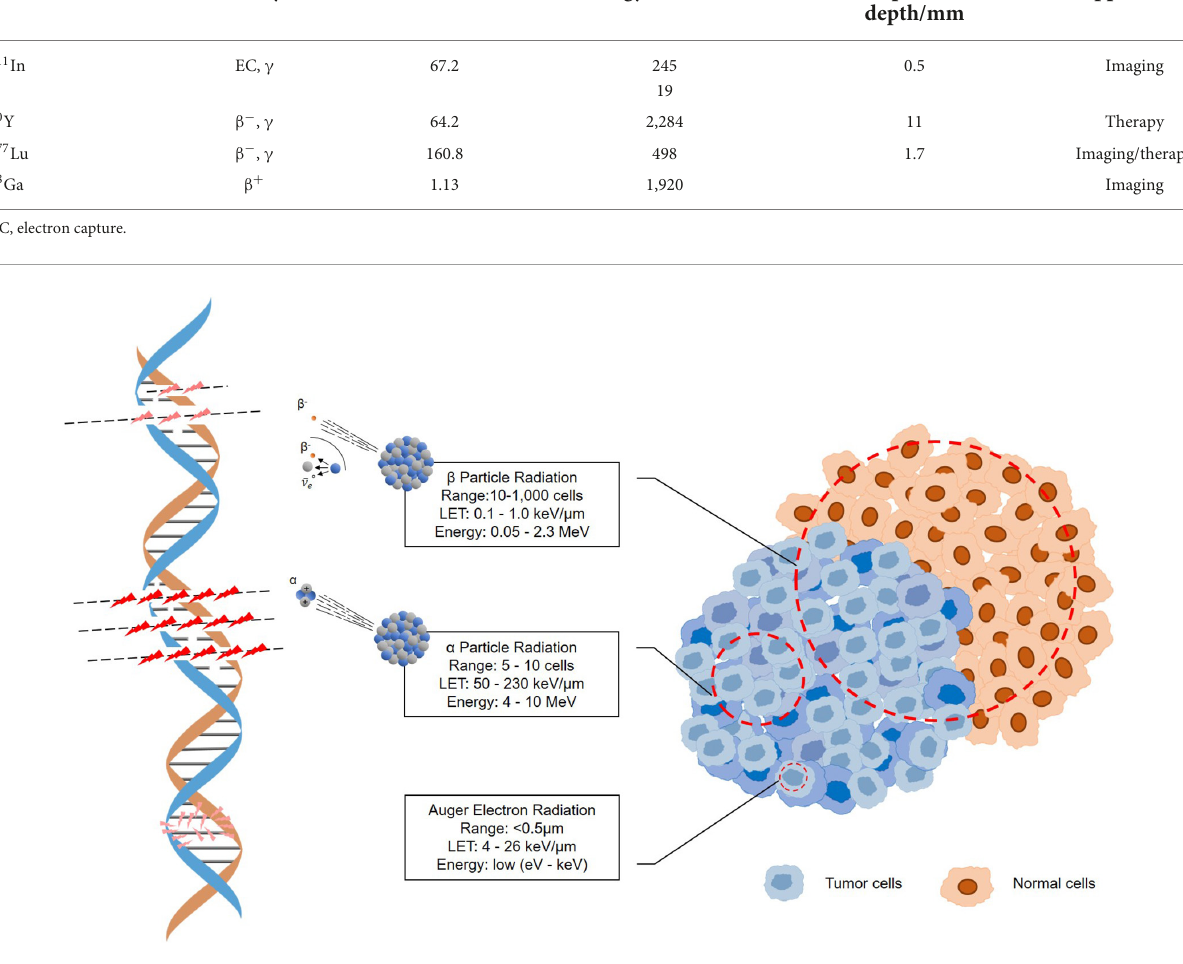
FIGURE3 Illustration of the tracks of α -particle, β -particle, and auger election